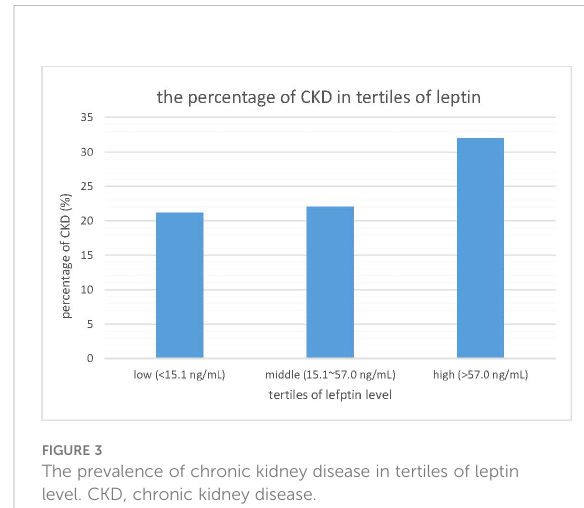
FIGURE 3 The prevalence of chronic kidney disease in tertiles of leptin level. CKD, chronic kidney disease.